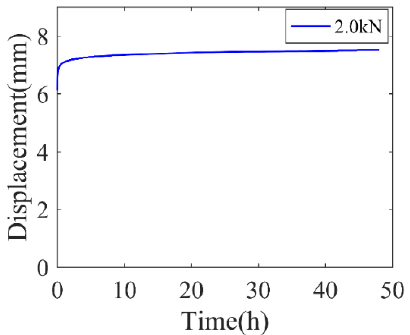
Figure 6. Time-deformation curve of rubber vibration system in creep test.